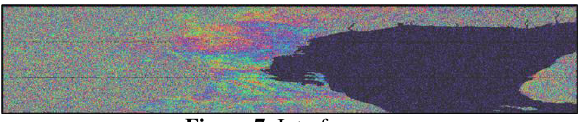
Figure 7. Interferogram